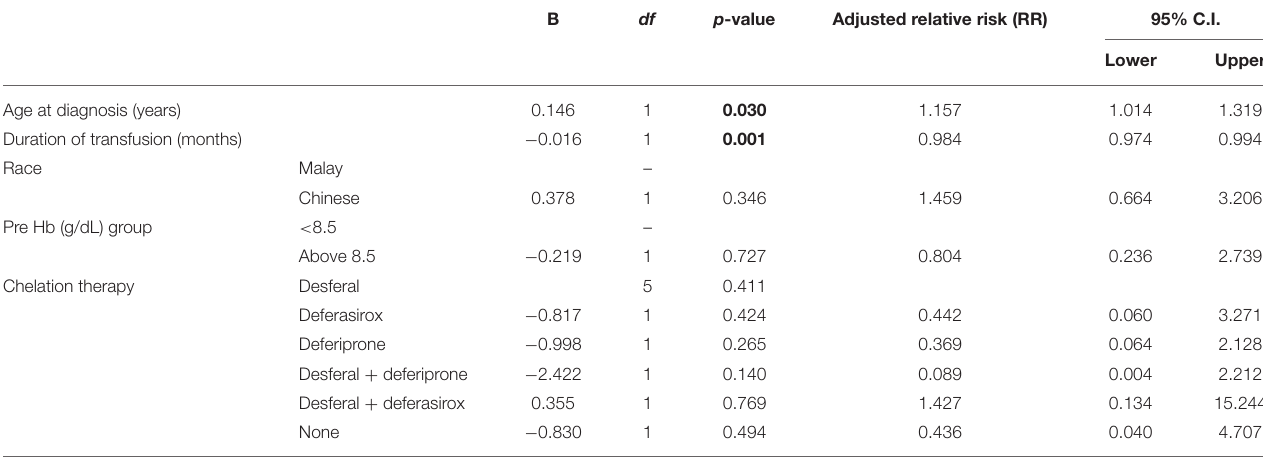
TABLE 2 | Multivariable analysis of patients with transfusion-dependent thalassemia.